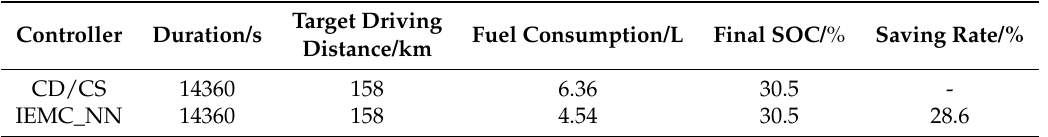
Table 3. Fuel economy comparison for the unknown driving distance information condition (LA92